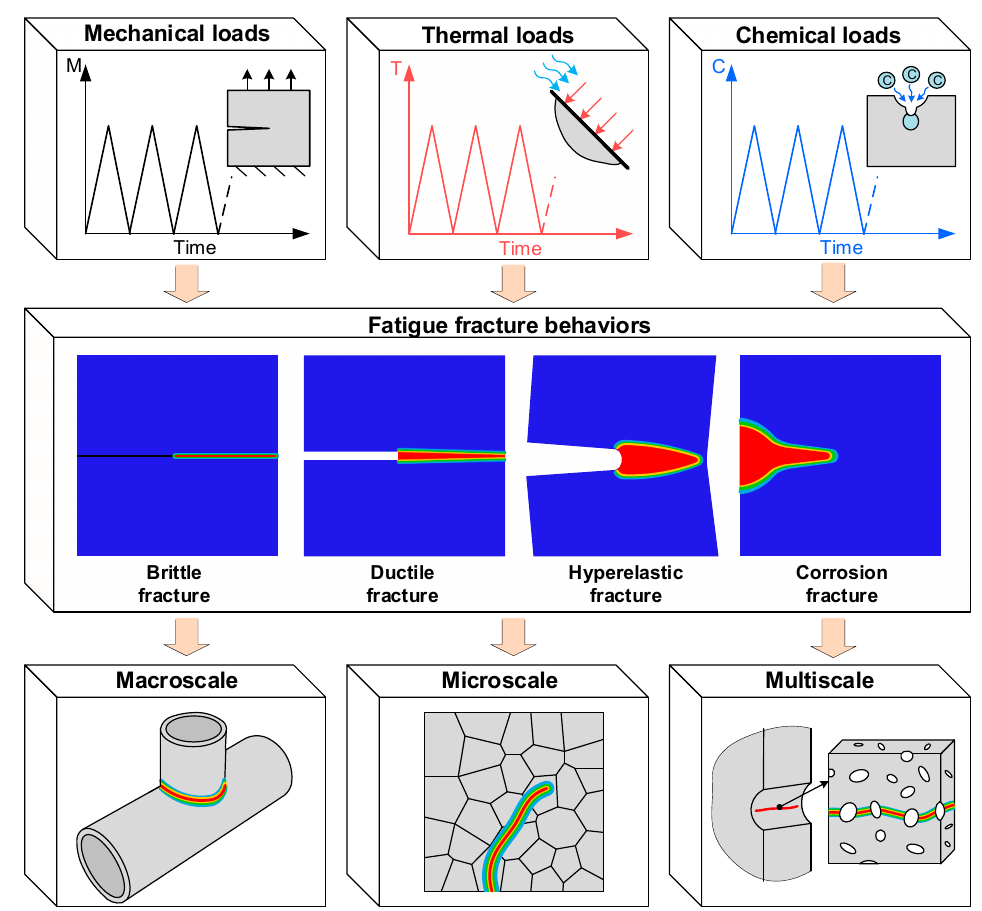
Figure 1. Fatigue fracture behaviors simulated with phase fi eld methods.